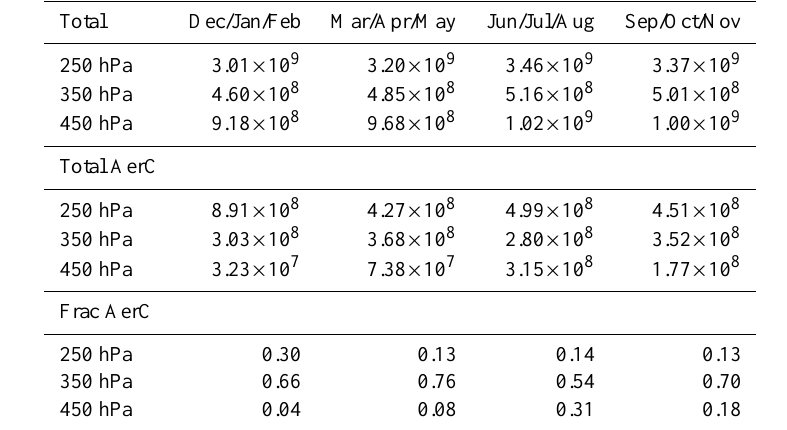
Table 1. 1st part – total flight distances (in km) on the respective flight levels; 2nd part – flight distances with the possibility of aerodynamic contrail formation; 3rd part – fractions of the total flight distances where aerodynamic contrail formation is possible.